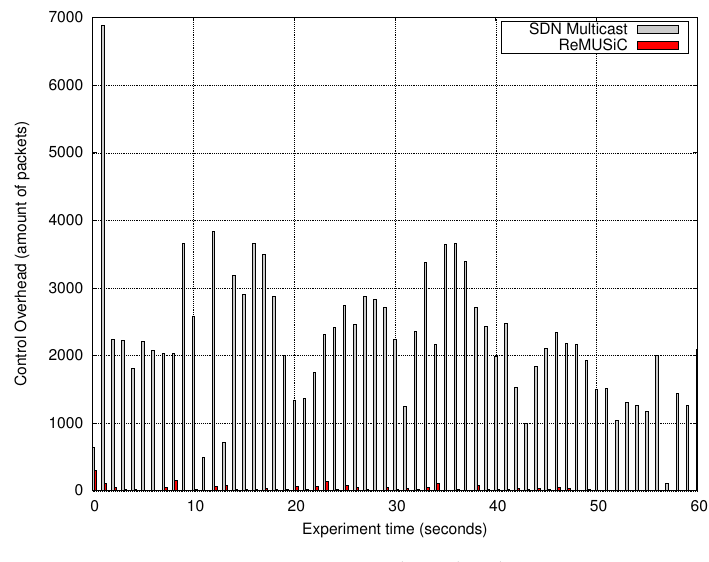
Figure 11. Control overhead.